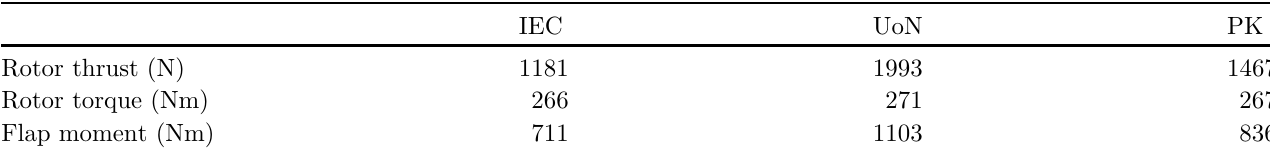
Table 3. Ten-min maximum rotor